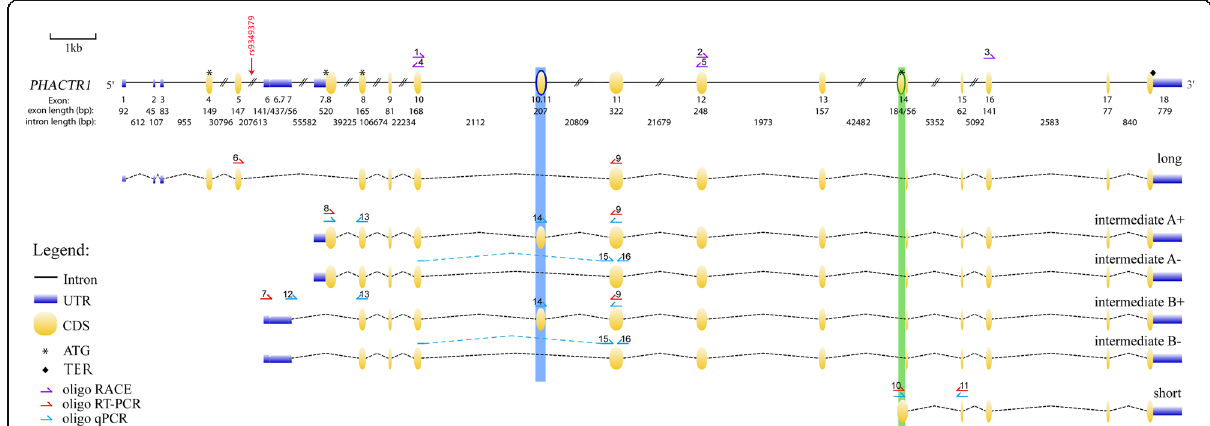
Fig. 1 Six PHACTR1 transcripts are expressed in human samples. We combined Rapid Amplification of cDNA Ends (RACE) and long-read DNA sequencing (Pacific Biosciences) to identify all PHACTR1 mRNA transcripts expressed in human samples. Although we identified multiple transcripts, they give rise to six main transcripts. The schematic diagram shows the PHACTR1 gene (top) and the six main transcripts below. The coronary artery disease-associated SNP rs9349379 (red arrow) is located in a large intron (207,613-bp) between exons 5 and 6. The start codons for the long, intermediate A, intermediate B and short transcripts are located, respectively, in exons 4, 7.8, 8, and 14. The stop codon for all six transcripts is in exon 18. In blue, we highlight the in-frame, 207-bp long, exon 10.11 that is included in intermediate transcripts A+ and B+. In green, we highlight part of exon 14 that is specific to the short transcript. We also indicated the different oligonucleotides used in our